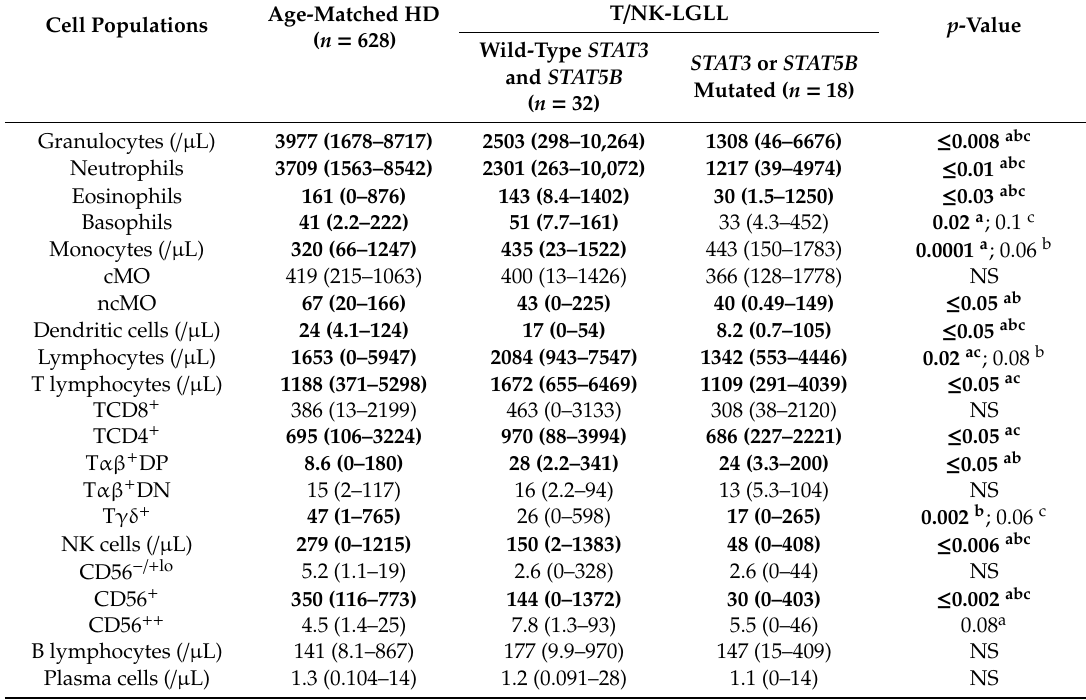
Table 2. Distribution of normal PB leukocyte subsets in T / NK-LGLL according to their STAT3 or STAT5B mutational